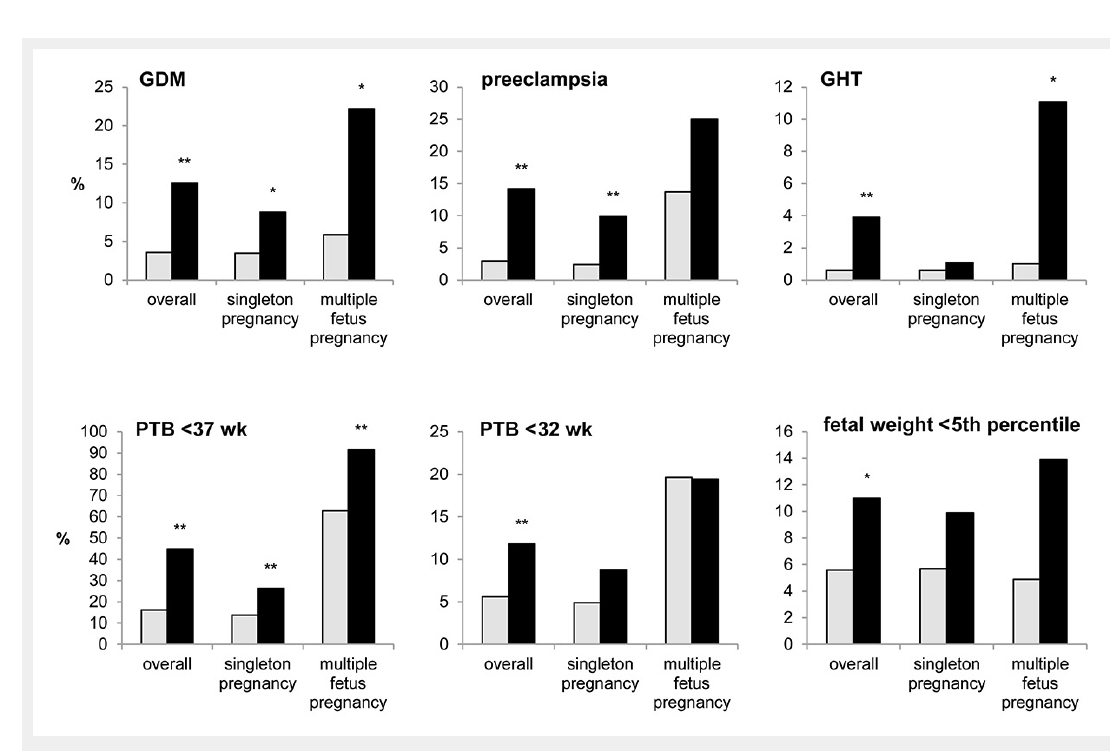
Figure 1 Incidence (%) of adverse maternal and infant outcome in very advanced maternal age (VAMA) patients (black) and 30-year-old patients (grey) within the overall group and within subgroups (singleton and multiple-fetus pregnancies). GDM = gestational diabetes mellitus; GHT = gestational hypertension; PTB = preterm birth; wk = weeks of gestation ** p<0.01, * p<0.05 (chi-square